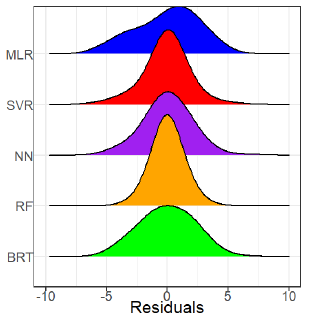
Figure 14. ML model residuals distribution for the training